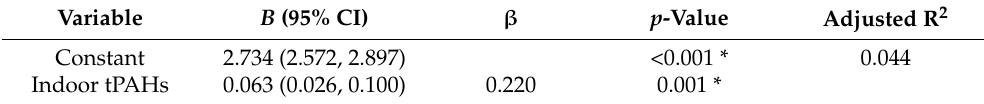
Table 3. Factor that influences DNA damage among children after controlling all confounders. Variable B (95% CI)